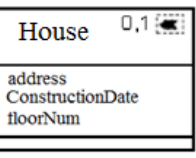
Figure 3. Example of fuzzy facultative geometry